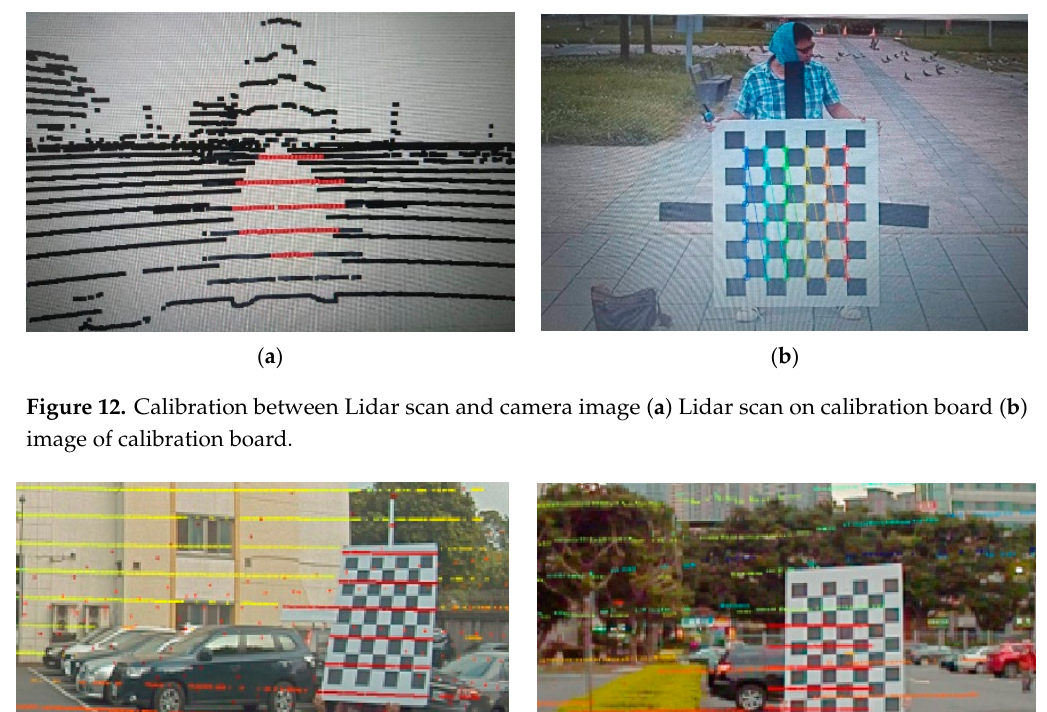
Figure 11. Flowchart of extrinsic calibration between camera and Lidar sensors.